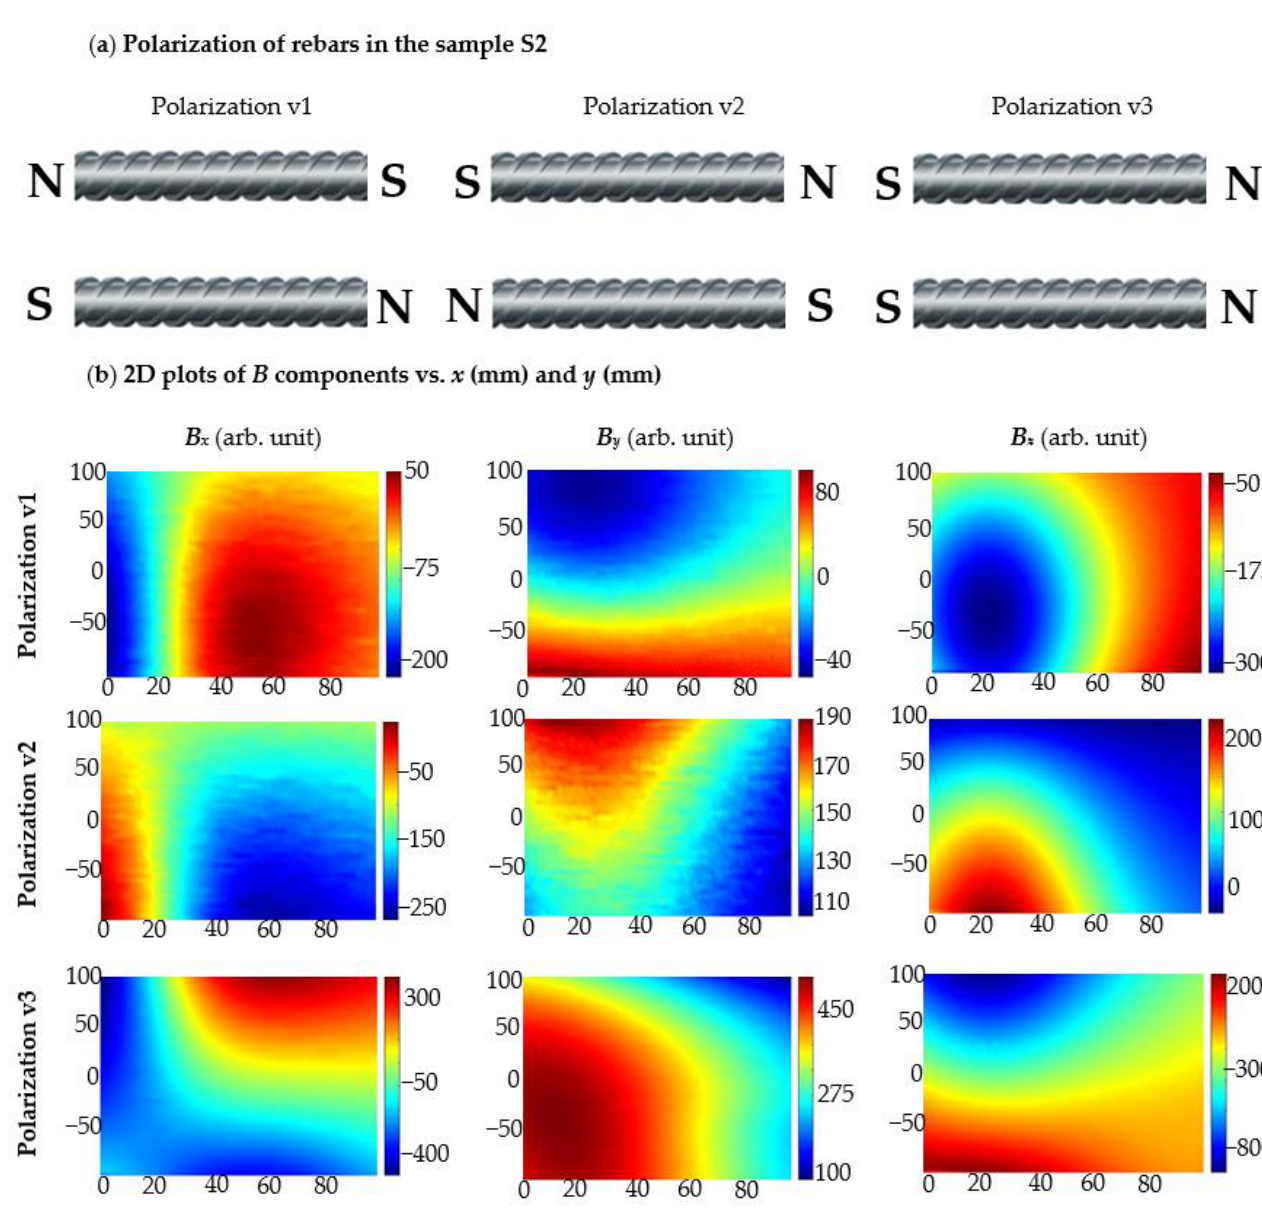
22 of 29 Figure 21. Results of 2D measurements using AMR sensor obtained for different samples (S1, S2, S3); without magnetization; thickness of the concrete cover h = 40 mm; x (mm), y (mm) — sensor